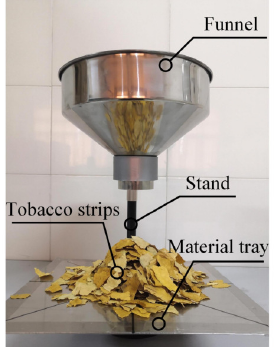
Figure 1. Stacking angle measuring instrument.